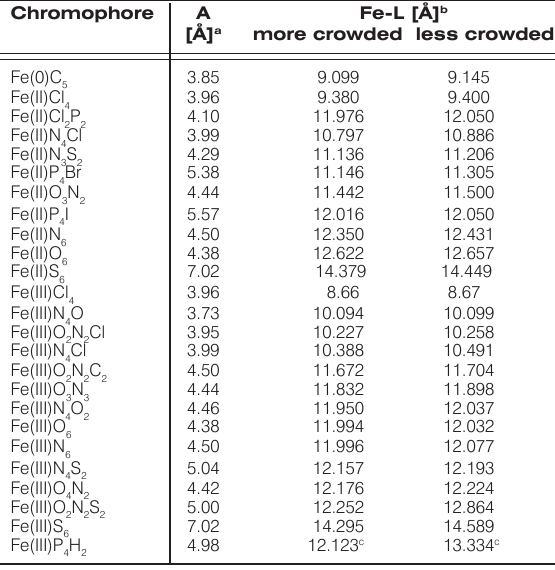
Table 3. Summary of the sum of Fe-L (x n) (n = 4,5 or 6) bond distances in distortion isomers (monomeric)